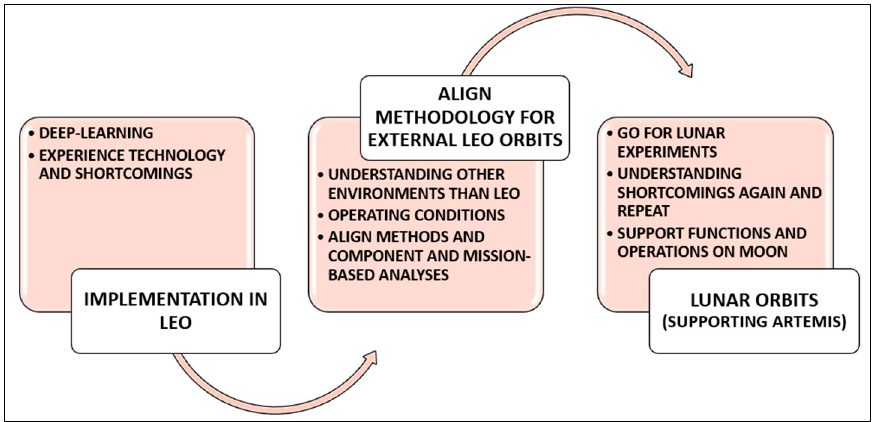
Figure 5. Lunar mission strategy.